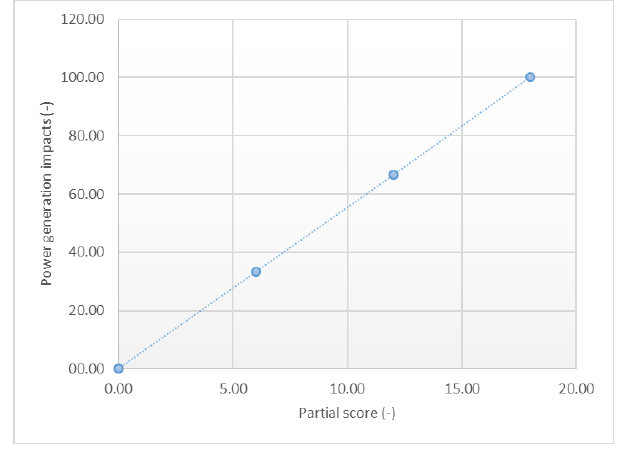
Figure 8. Power generation impacts coefficient value function.